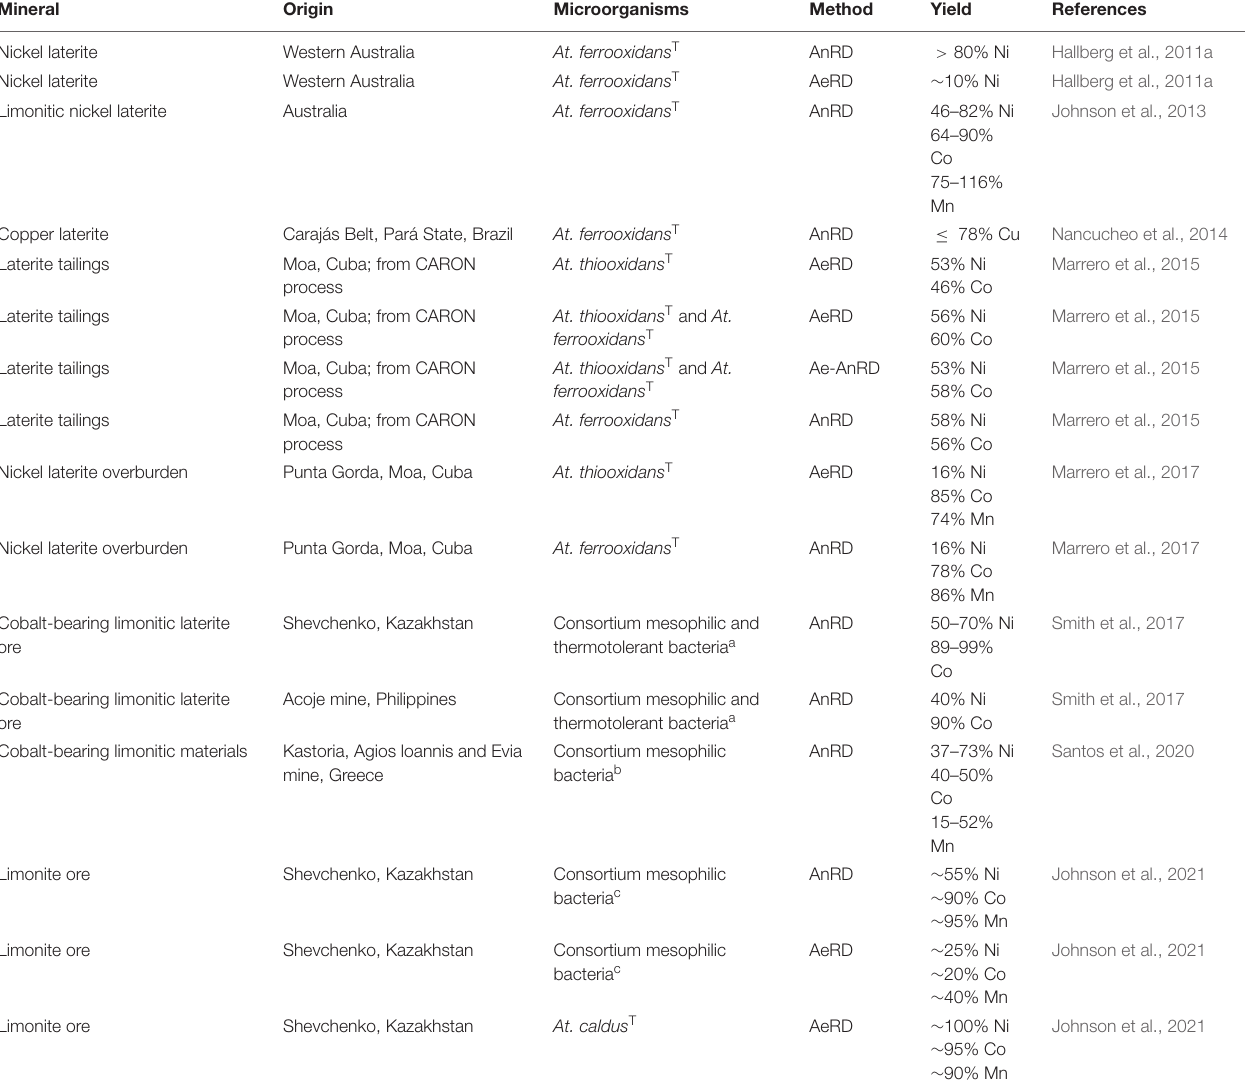
TABLE 6 | Overview of reductive mineral dissolution using extreme